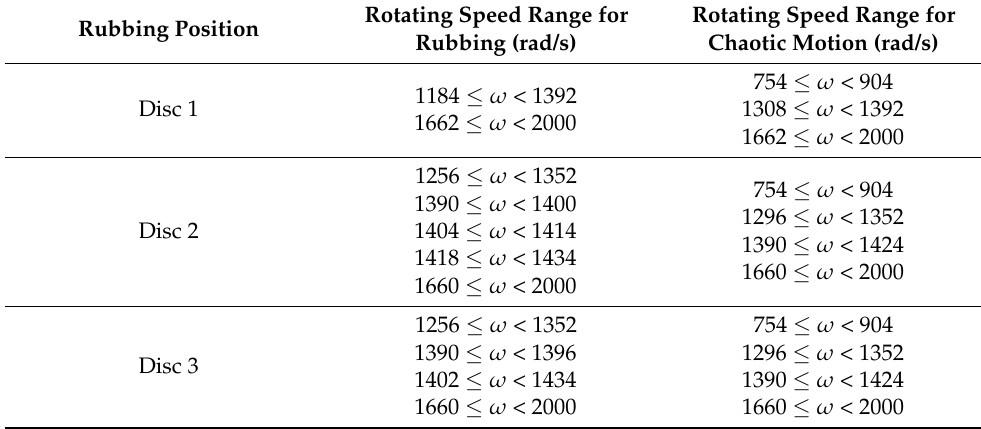
Figure 16. Bifurcation diagrams of disc 1 for the case of disc 4 subjected to rub-impact: